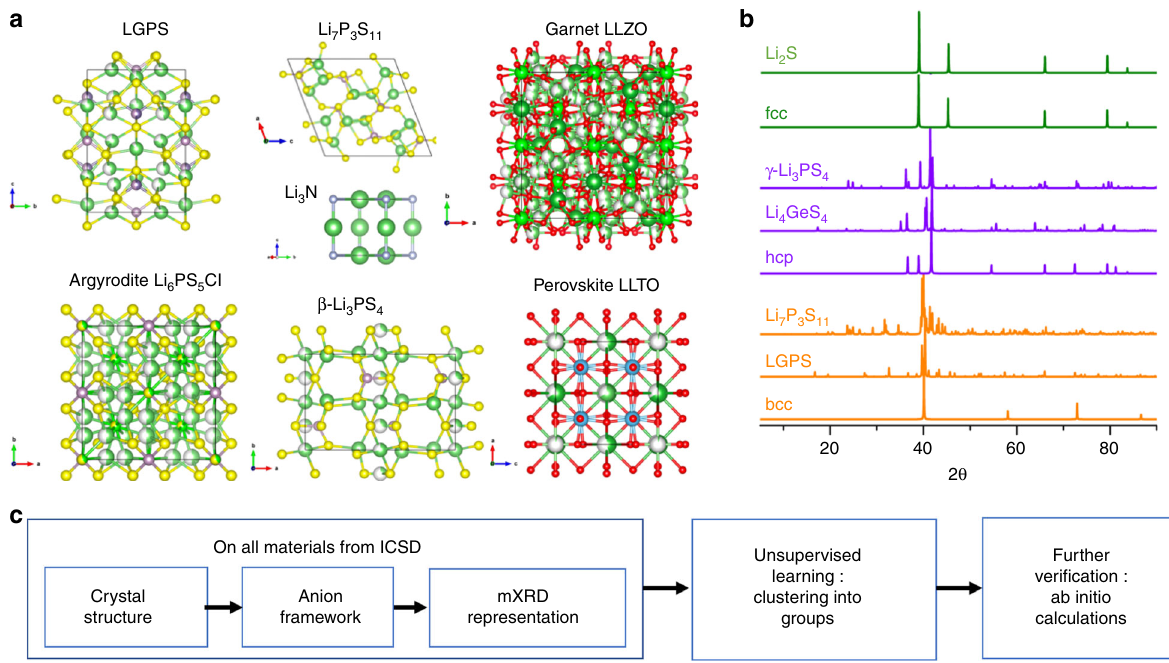
Fig. 1 Schematics of the unsupervised discovery of solid-state Li-ion conductors. a Crystal structures of known SSLCs, showing a large diversity of structure and chemistry. b mXRD patterns of selected materials in comparison to those of ideal fcc (face centered cubic), hcp (hexagonal close packed), bcc (body centered cubic) lattices. c Work fl ow of an unsupervised learning guided discovery of